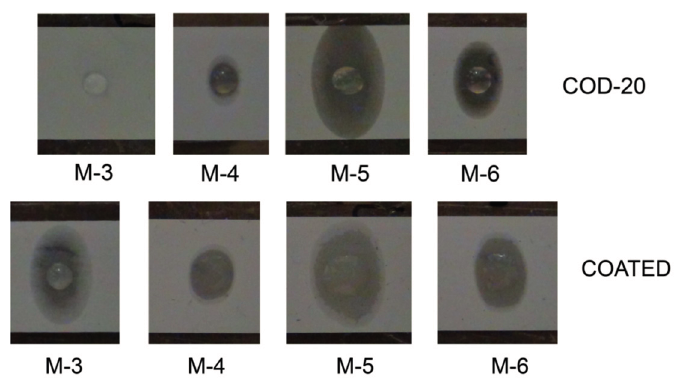
Figure 9. Representative photographs of drops onto separator foils 5 h after dropping (inside glove box) with selected mixtures: ( Above ) separator COD-20; and ( Below ) separator